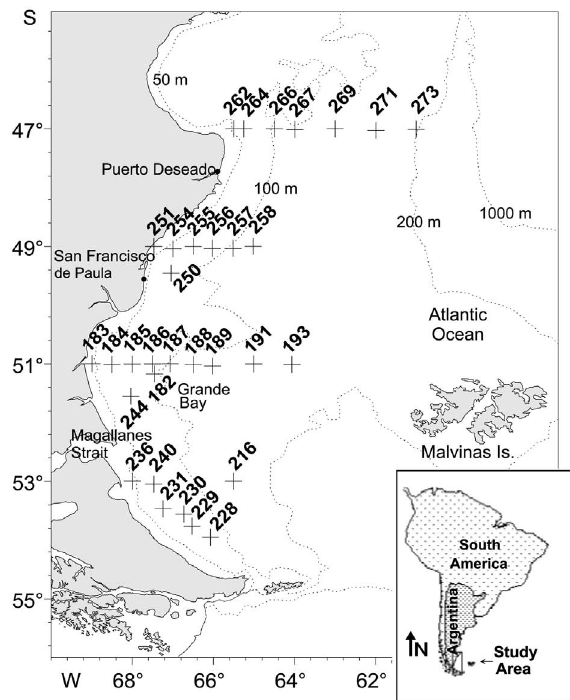
Fig. 1. – Mesozooplankton sampling stations (crosses) over the southern Patagonian shelf during the cruise EH-03/04 (INIDEP) carried out in late summer March/April, 2004 onboard RV Dr. E.L Holmberg